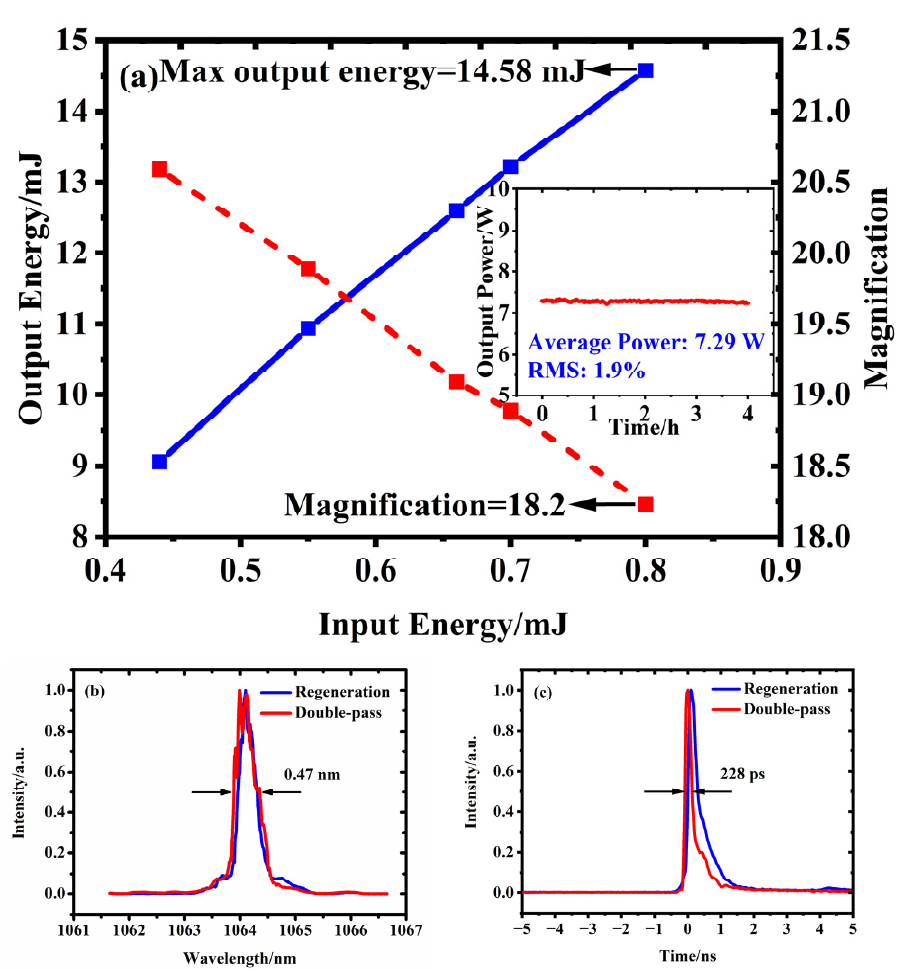
Figure 7. ( a ) Output energy and magnification of the Nd:YAG double-pass amplifier. The inset shows the power stability of the laser source in 8 h. ( b ) Spectrum distribution of regenerative amplifier and double-pass amplifier. ( c ) Temporal profiles of the regenerative amplifier and double-pass amplifier.